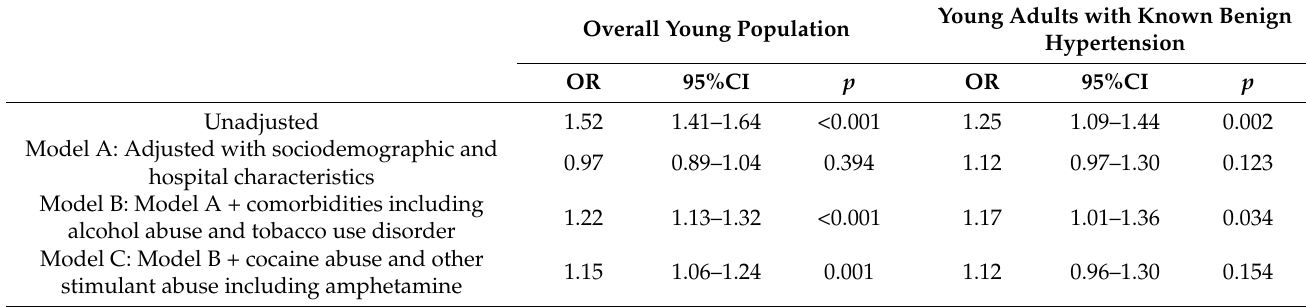
Table 2. Association Of Cannabis Use Disorder With Hypertensive Crisis-related Hospitalizations In Overall Young Adult Population Additionally, Young Adults With Known Benign Hypertension.